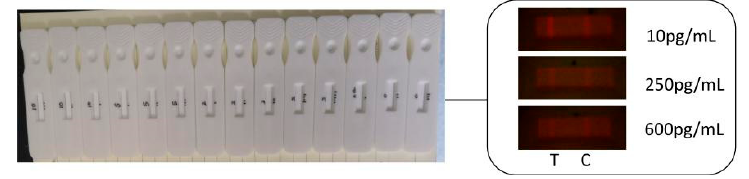
Figure 8. AFB1 test strips and collected images.